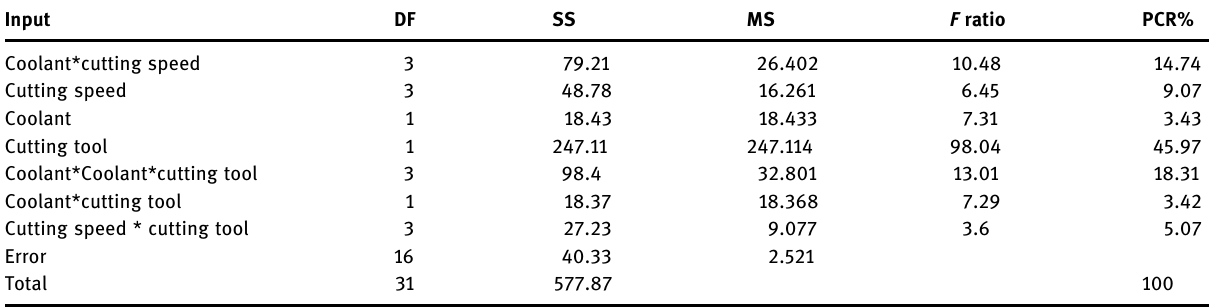
Table 4: ANOVA results for F top